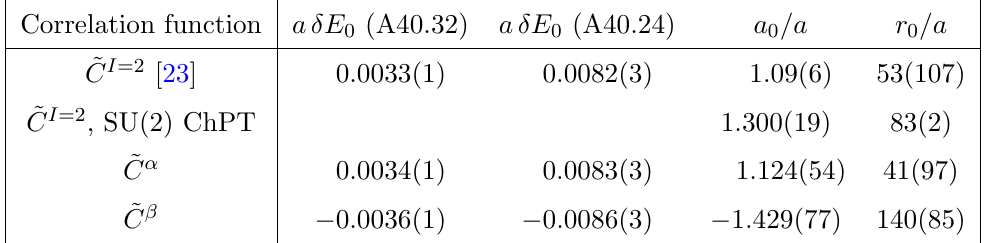
Table 1 . The (cid:12)tted energy shifts, the extracted inverse scattering lengths and e(cid:11)ective ranges (with a pion mass in in(cid:12)nite volume of about 323 MeV) obtained using the connected (cid:25)(cid:25) correlation functions. Notice that (cid:14)E (cid:11) is just the I = 2 (cid:25)(cid:25) energy shift. For comparison, we list the I = 2 0 values with the corresponding statistical errors in the original lattice paper [23] in the second row, and include the NLO ChPT predictions of the I = 2 threshold parameters in the third row.